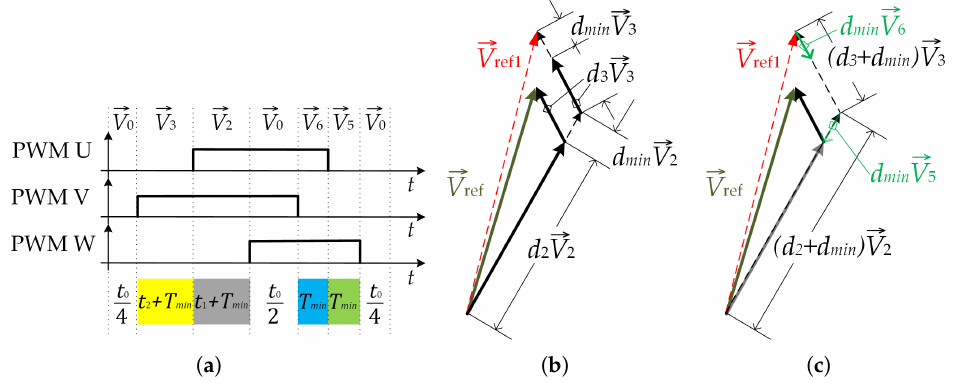
Figure 4. SVM pattern for Region 2: ( a ) vectors versus time intervals; ( b ) injection of vectors d min (cid:126) V 2 and d min (cid:126) V 3 ; ( c ) injection of collinear vectors d min (cid:126) V 5 and d min (cid:126) V 6